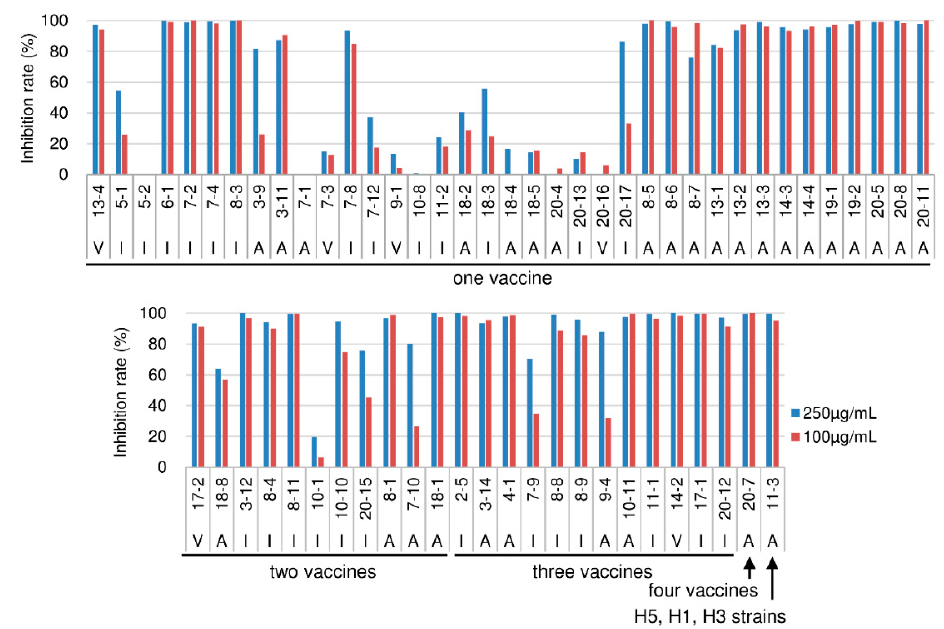
Figure 2. Neutralization activity of Fab-PP from HI-positive clones was measured by the focus reduction assay. Neutralization activity was tested at two antibody concentrations (250 µ g / mL, blue bars; and 100 µ g / mL, red bars). Three kinds of H5N1 viruses were tested, including V: Vie04 (Clade 1), I: Ind05 (Clade 2.1), and A: Anh05 (Clade 2.3); the strain used for each assay is indicated under the clone name. The neutralization activity is shown as the focus reduction rate (%) normalized to that observed in the absence of antibody.